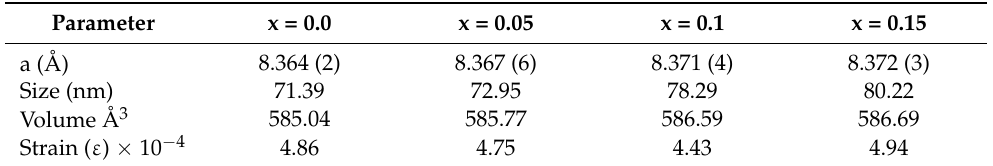
Figure 2. XRD patterns of CoW x Fe 2 − 2x O 4 spinel ferrites. Table 1. Refined values of cell parameters a (Å), crystallite size (nm), and microstrain ( ε ) of CoW x Fe 2 − 2x O 4 spinel ferrite system.